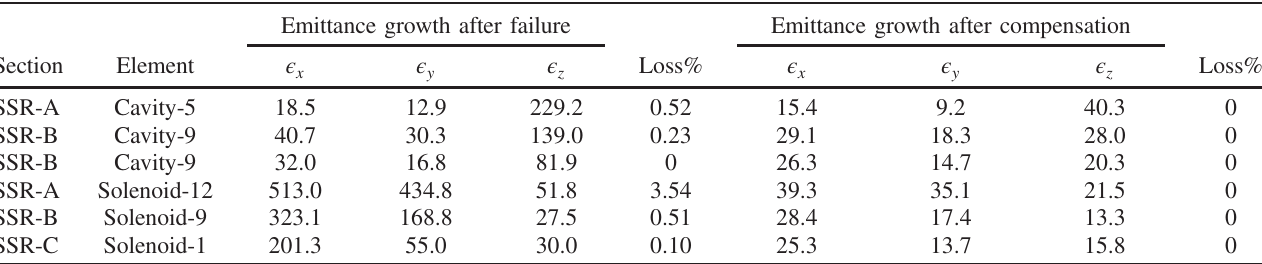
TABLE XI. Beam emittance and beam loss at the exit of the linac with the failure of the critical elements and after compensation. Emittance growth after failure Emittance growth after compensation Section